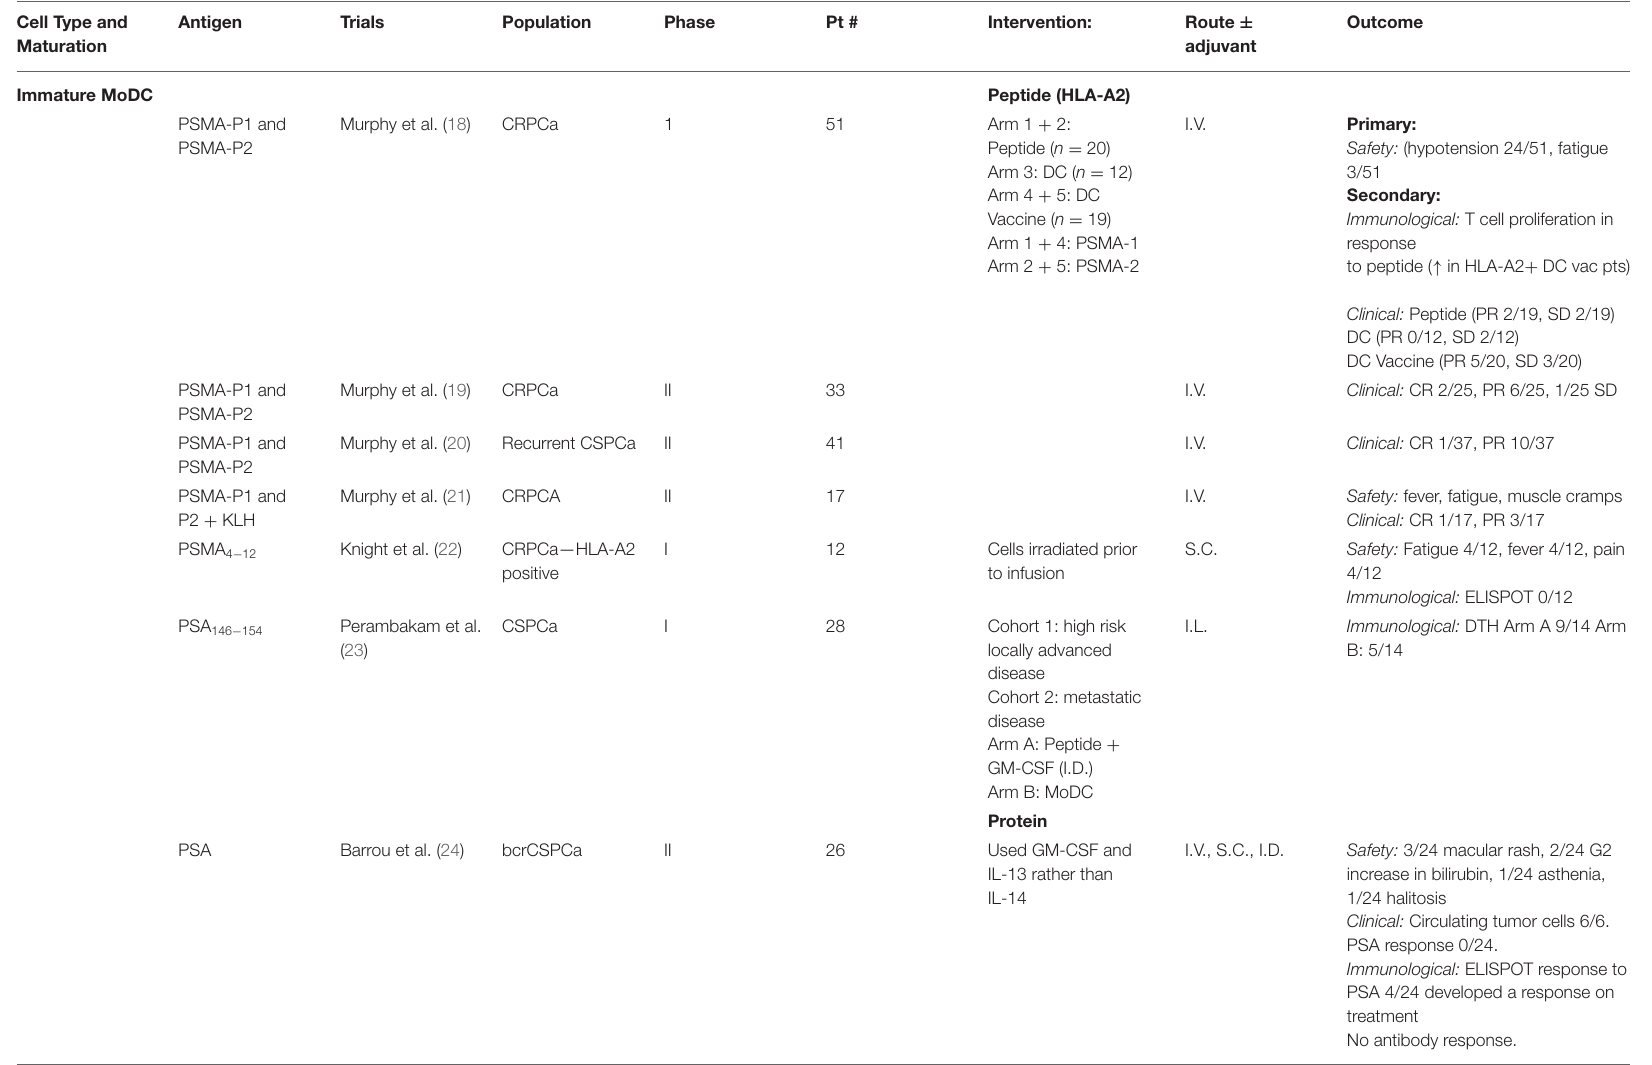
TABLE 1 | Published DC vaccination trials in prostate